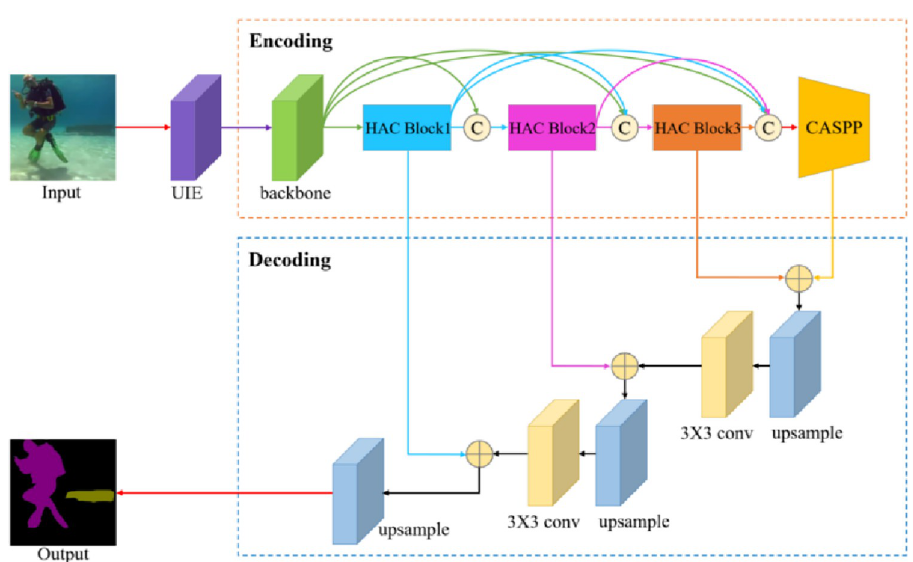
Fig 2. The pipeline of the proposed method.